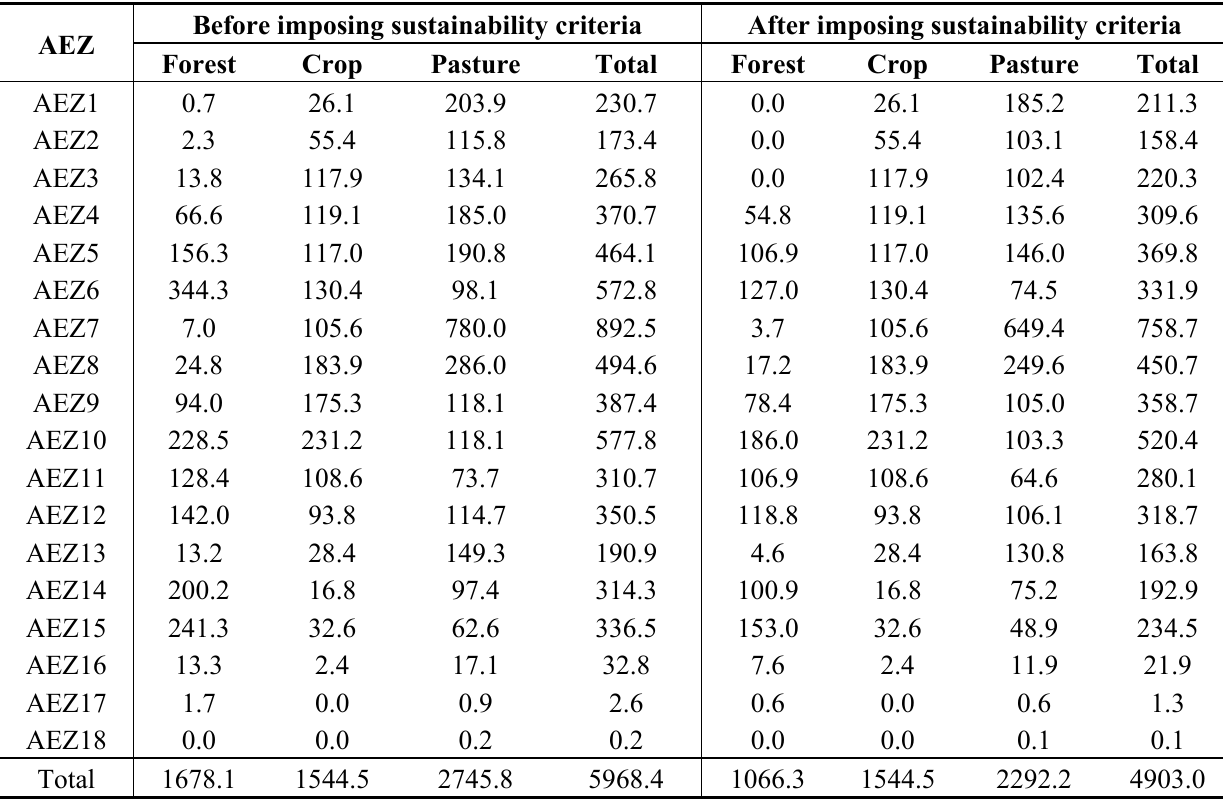
Table 1. The pool of global managed land before and after imposing sustainability criteria defined in the US and EU biofeul programs by agro ecological zone (AEZ)—(figures are in million